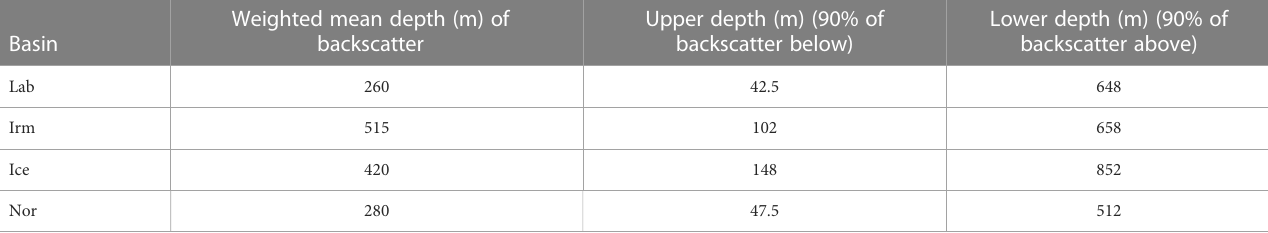
TABLE 3 Weighted Mean Depth (WMD) and estimated depth ranges of B. glaciale in the different basins based on vertical extension of 80% of total 38 kHz backscatter for non-schooling components. Weighted mean depth (m) of Upper depth (m) (90% of Basin backscatter backscatter